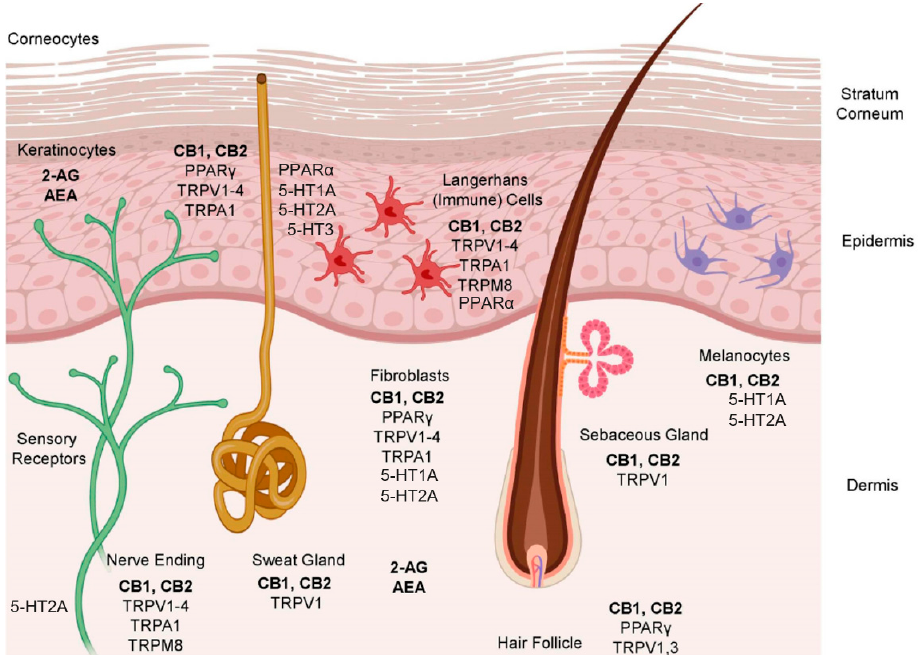
Figure 2. The repartition of CB1 and CB2, the TRPV1-4 channels, the TRPM8 channel, the PPARs transcription factors, and serotonin 5-HT1A, 5-HT2A, 5-HT3 receptors in skin cells, modificated with the permission of Dove Medical Press, Macclesfield, United Kingdom [61].